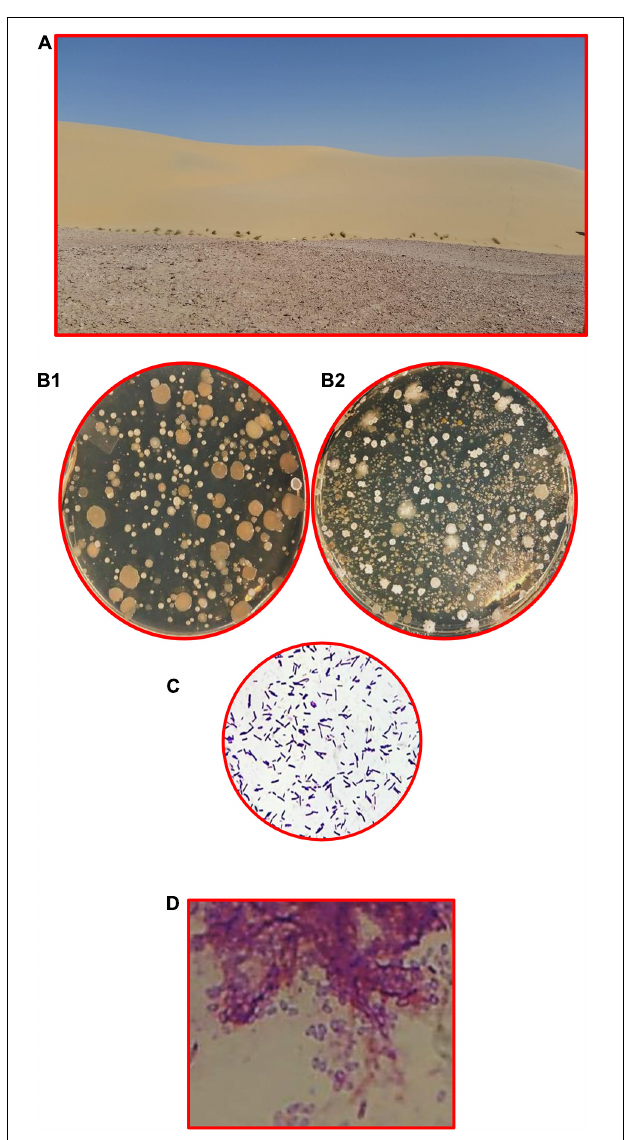
FIGURE 5 | Dunes are rich in BSC, including bacteria. (A) Qatari desert rich of xerophytes, (B1) non-rhizosphere soil of dune contains various types of bacteria (five to seven types of colonies, total bacterial counts: 8 × 10 3 cfu/g dry soil), (B2) rhizosphere soil contains high microbial activities (many types of colonies, total bacterial counts: 14 × 10 3 cfu/g dry soil), the most common bacteria are Gram-positive bacilli, spore-forming and non-spore-forming. (C) Non-spore forming and (D) spore-forming